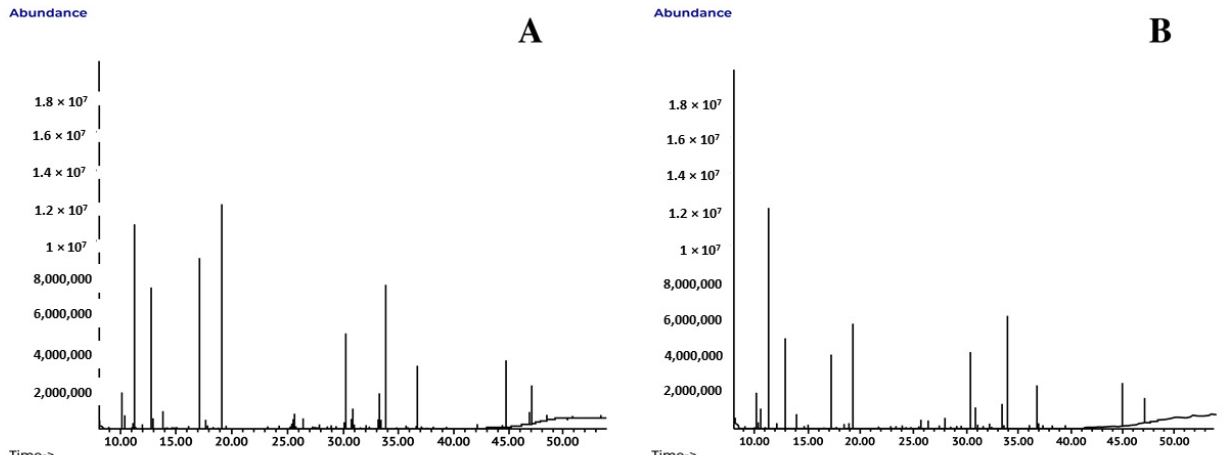
Figure 2. Gas chromatograms of the hydroalcoholic extracts of C. crassa collected in Ecuador ( A ) and Peru ( B ). Table 2. Compounds identified in the hydroalcoholic extract from C. crassa collected in Ecuador